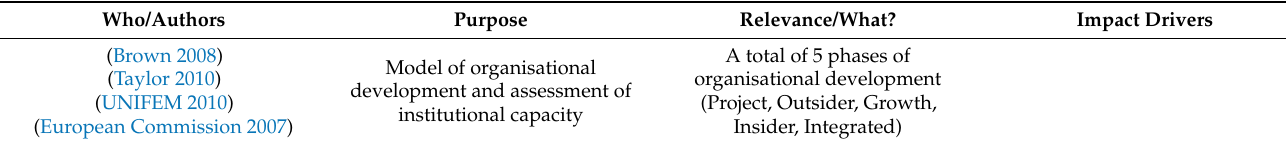
Table 1. An overview of the development of the Impact Driver